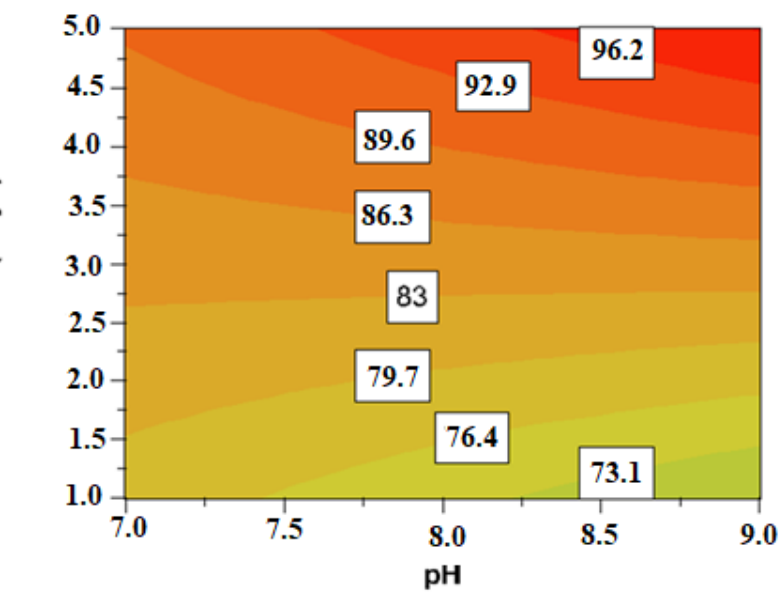
Figure 1. Response surface for the bioremediation process optimization in the function of the variables pH and treatment time with the bacteria without biofilms (the values on the figure indicate the removal achieved in terms of a percentage).